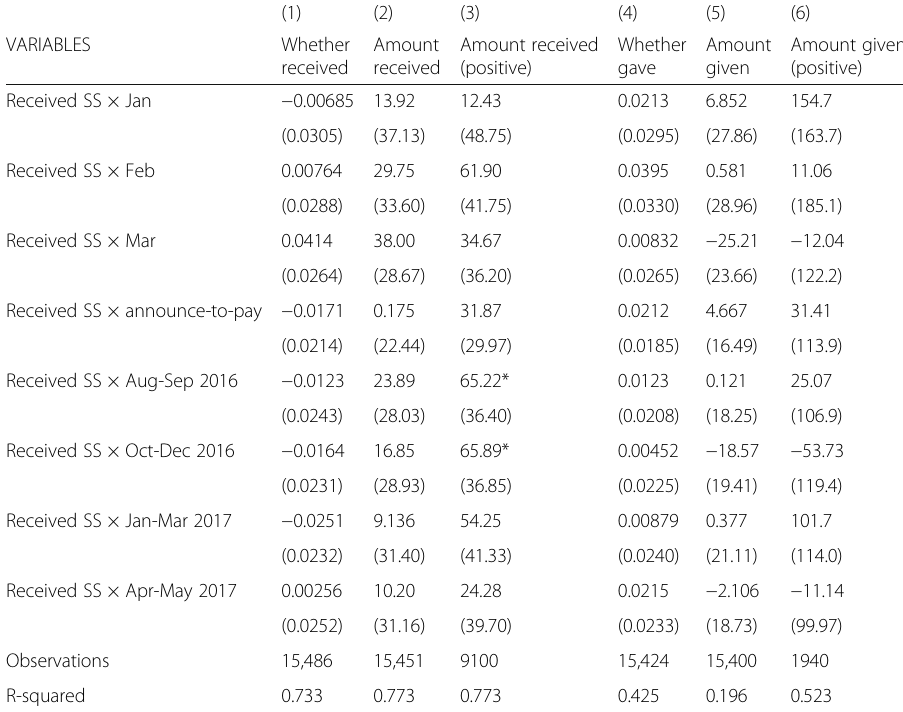
Table 5 Temporal impact of receiving SSS payouts on private cash transfers